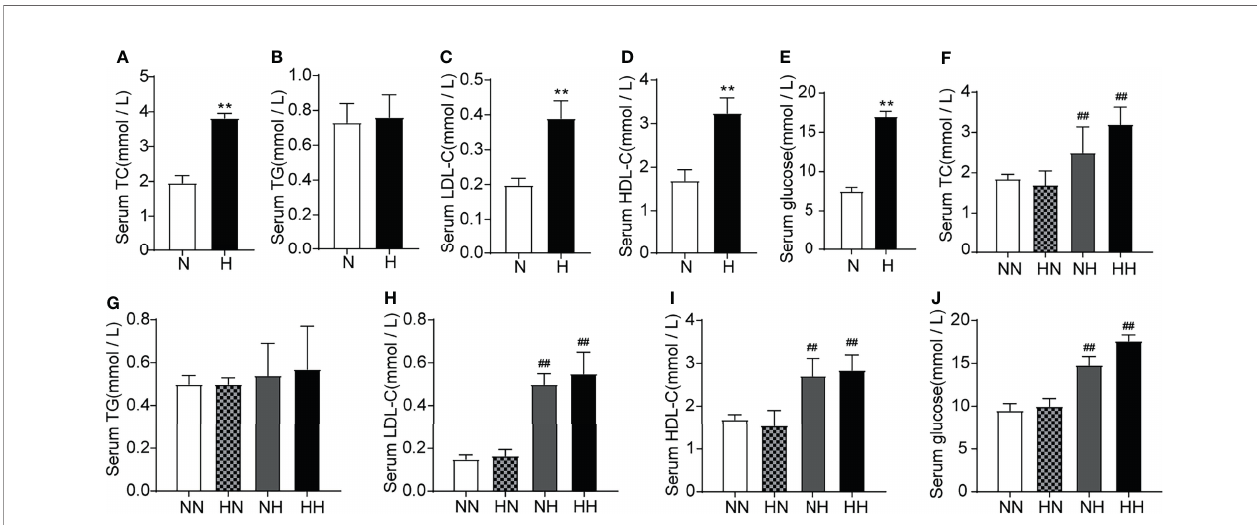
FIGURE 2 | Lipid pro fi leinduced byhigh-fat diet duringsexual development the levelof serum TC, TG, LDL-C, HDL-C andserum glucose between normal diet (N) and high-fat diet(H) group of8-week old mice (n=8 for each group). (A – E) . The levelof serum TC, TG, LDL-C, HDL-C andserum glucose of16-weekold mice among NN group, HN group, NH group and HH group (n=8 for each group). (F – J) Results are presented as mean ± SEM. **p < 0.01 vsthe N group. ##p< 0.01 vsthe NN